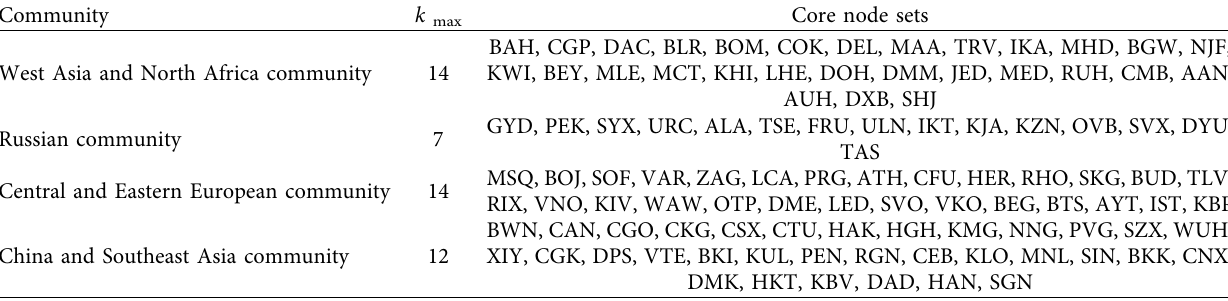
Table 3: Te core node set of the community